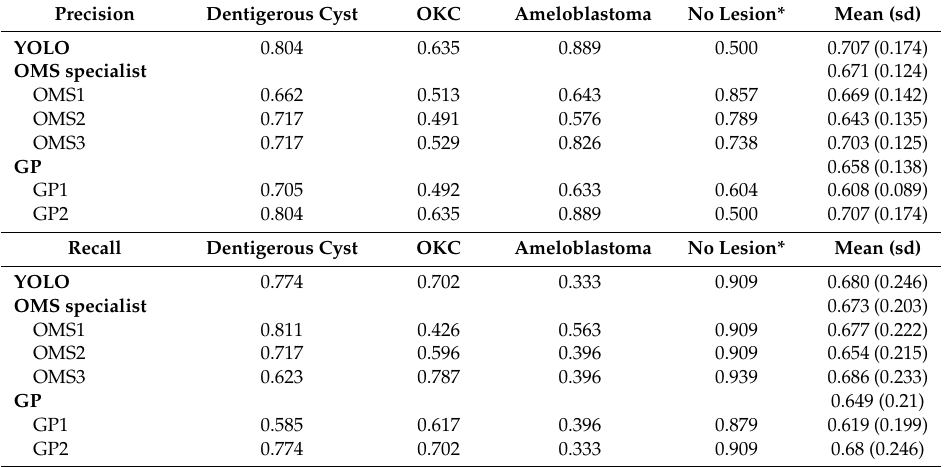
Table 2. Precision and recall of YOLO, OMS specialists, and general practitioner